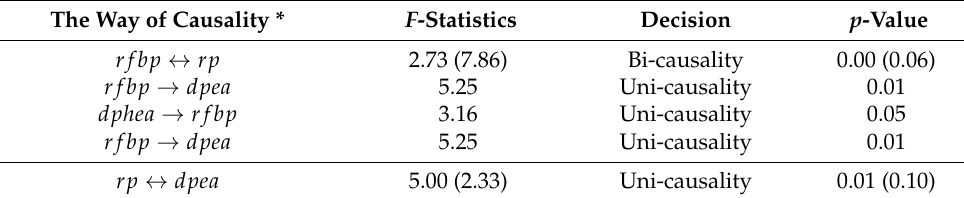
Figure A10. Time series forecasting in VAR model for rfbp, the in-sample January 2000–May 2012,